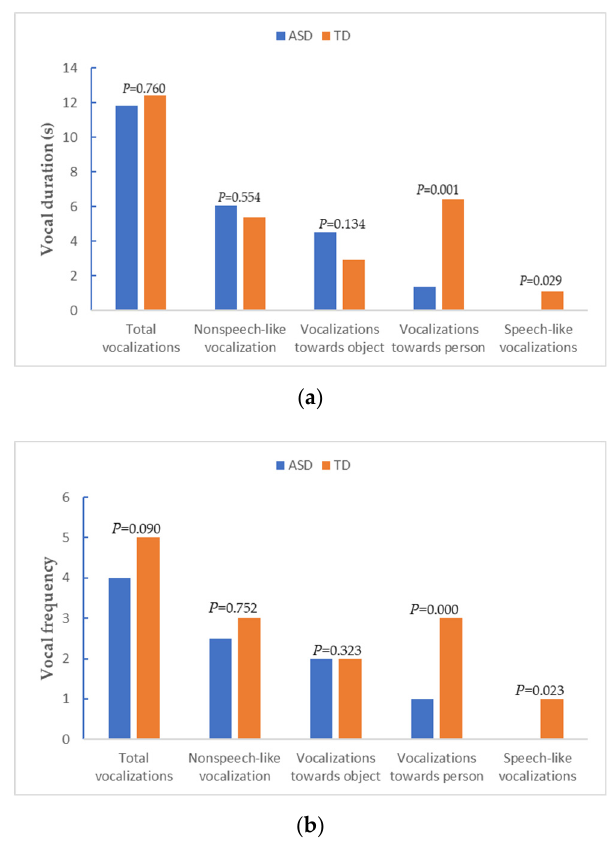
Figure 3. Comparison of SFP vocalizations between the ASD and TD groups: ( a ) vocal duration; ( b ) vocal frequency.